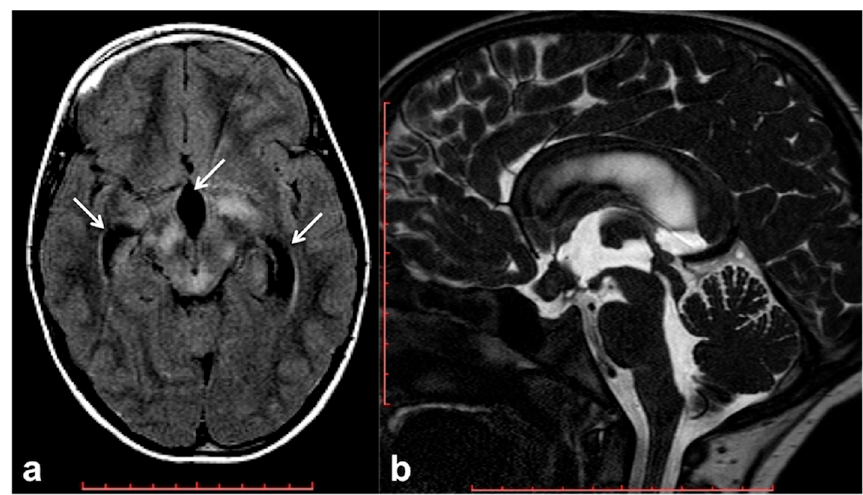
Figure 3. Brain MRI of a 6 year-old boy with NF1 and aqueductal stenosis: axial fluid attenuation inversion recovery (FLAIR) ( a ) showing bilateral basal ganglia and brainstem hyperintensities consistent with FASI. Supratentorial hydrocephalus with enlarged third ventricle and temporal horns of the lateral ventricles was also seen (white arrows); no transependymal CSF flow in periventricular areas was visible, and the fourth ventricle was normal. Sagittal 3D heavily T2-weighted sequence ( b ) revealed the presence of a thickened web in the cerebral aqueduct causing stenosis and hydrocephalus.